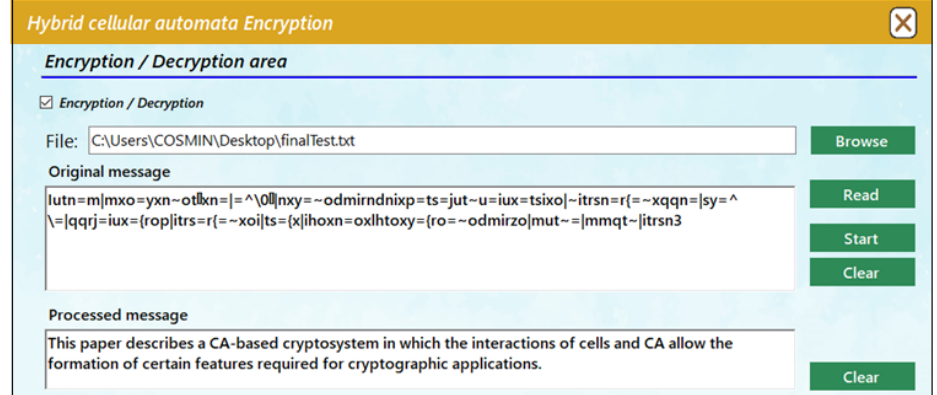
Figure 6. Results of the decryption process.